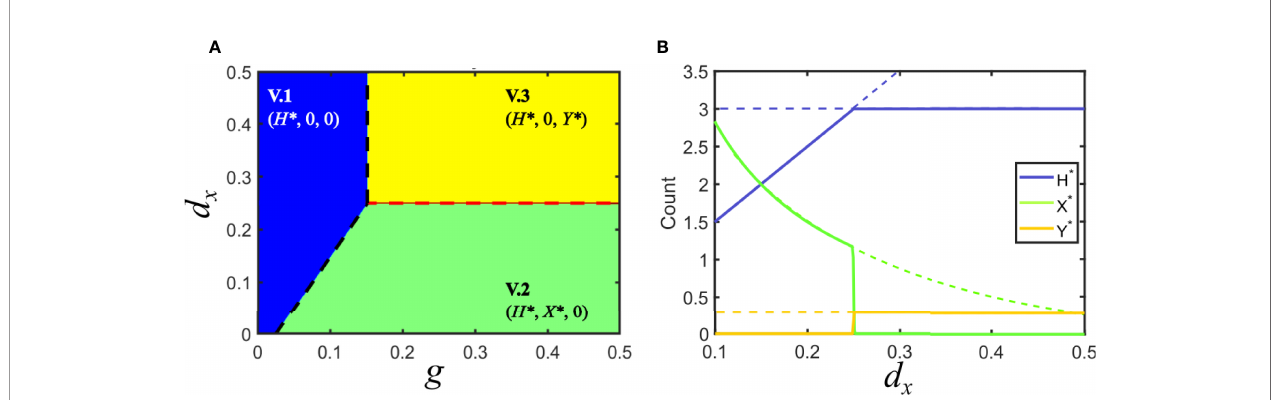
FIGURE 3 | Solutions for Model V in parameter space. (A) Phase space of solutions in the plane of the variables host growth ( g ) and increase in host death rate due to infection by virus x ( d x ). The different solutions are indicated by the legend, here and elsewhere. In the blue region, none of the viruses can invade the population of hosts, d / g > F i , i = x,y . The black dashed line indicates the boundary where d / g = F i . Green and yellow regions correspond to solutions that satisfy F x > F y and F y > F x, respectively, where one of the viruses invades the population of hosts and displaces the other. The red dashed line corresponds to the marginal coexistence solution. (B) Bifurcation diagram for a cross section of the phase space in A corresponding to g = 0.5. Lines indicate the amount of each class at the fi xed point, as shown in the legend. Dashed lines represent unstable solutions that are continued by solid lines corresponding to stable solutions. Green and yellow regions in A correspond to d x < 0.25 and d x > 0.25. Vertical lines show the degenerate solution of coexistence of the two viruses for d x = 0.25. Note that the values of H * and Y * become independent of d x in the region where y is the invading virus (and thus x becomes extinct). Parameters used: d = 0.05, p x = 0.1, p y = 0.1, d y =